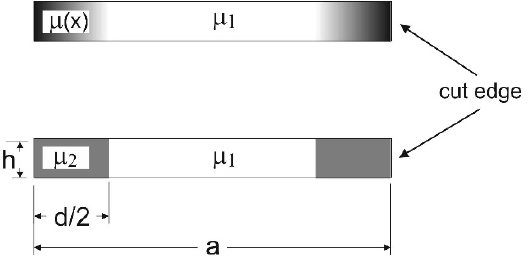
Figure 1. Comparison of a material model with properties dependent on the distance from the cut edge (upper) and a model with equivalent, homogeneous material properties (lower). The adopted material model, containing areas with uniform, equivalent magnetic permeability, is equivalent to the material model in which the magnetic permeability is a function of the distance from the cut edge. For partially damaged material, an